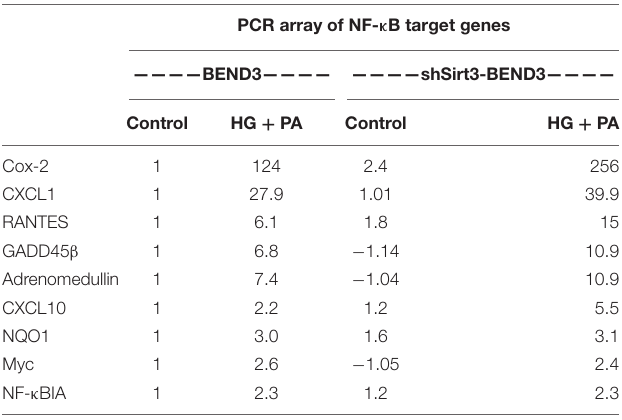
TABLE 1 | BEND3 and shSirt3-BEND3 cells were incubated in the absence (control) and presence of a combination of high glucose (30 mM) and palmitic acid (300 µ M) for 48